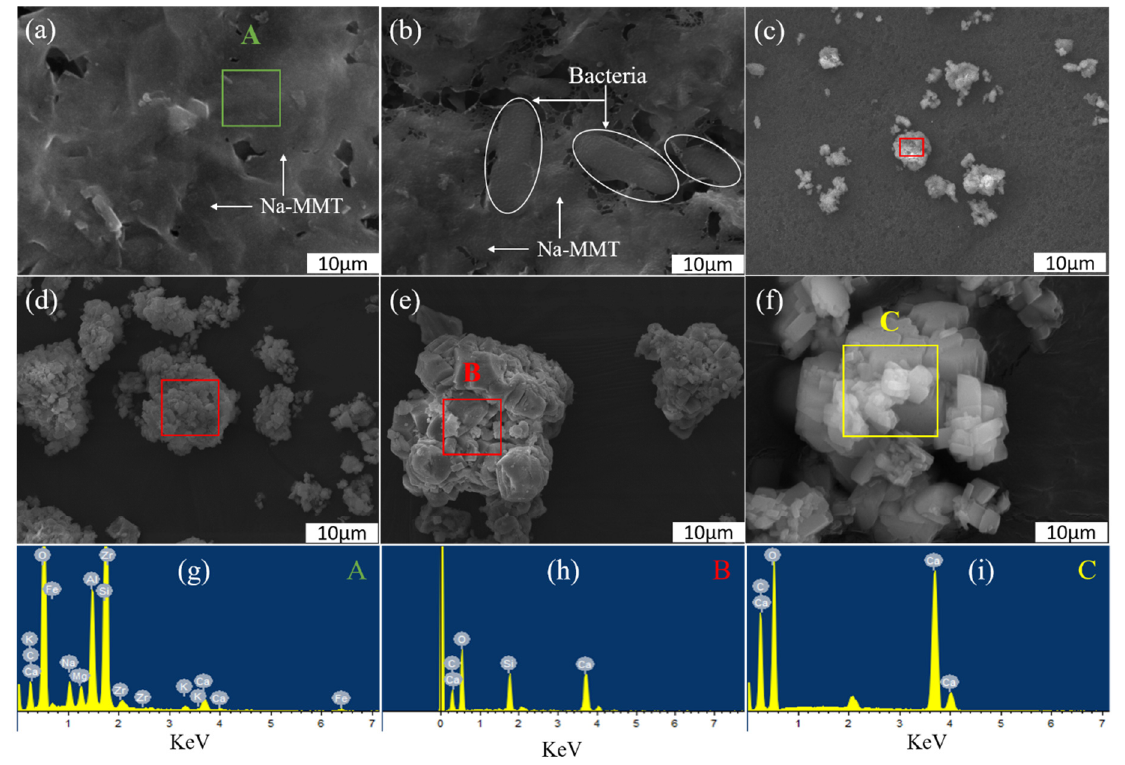
Figure 1. The SEM images of NA-MM ( a ) and CaCO 3 precipitates with Na-MMT obtained at various times: 1 min ( b ), 30 min ( c ), 60 min ( d ), 2 h ( e ), 24 h ( f ), respectively. The EDS patterns of Na-MMT and CaCO 3 precipitates from the marked area A ( g ), B ( h ) and C ( i ).